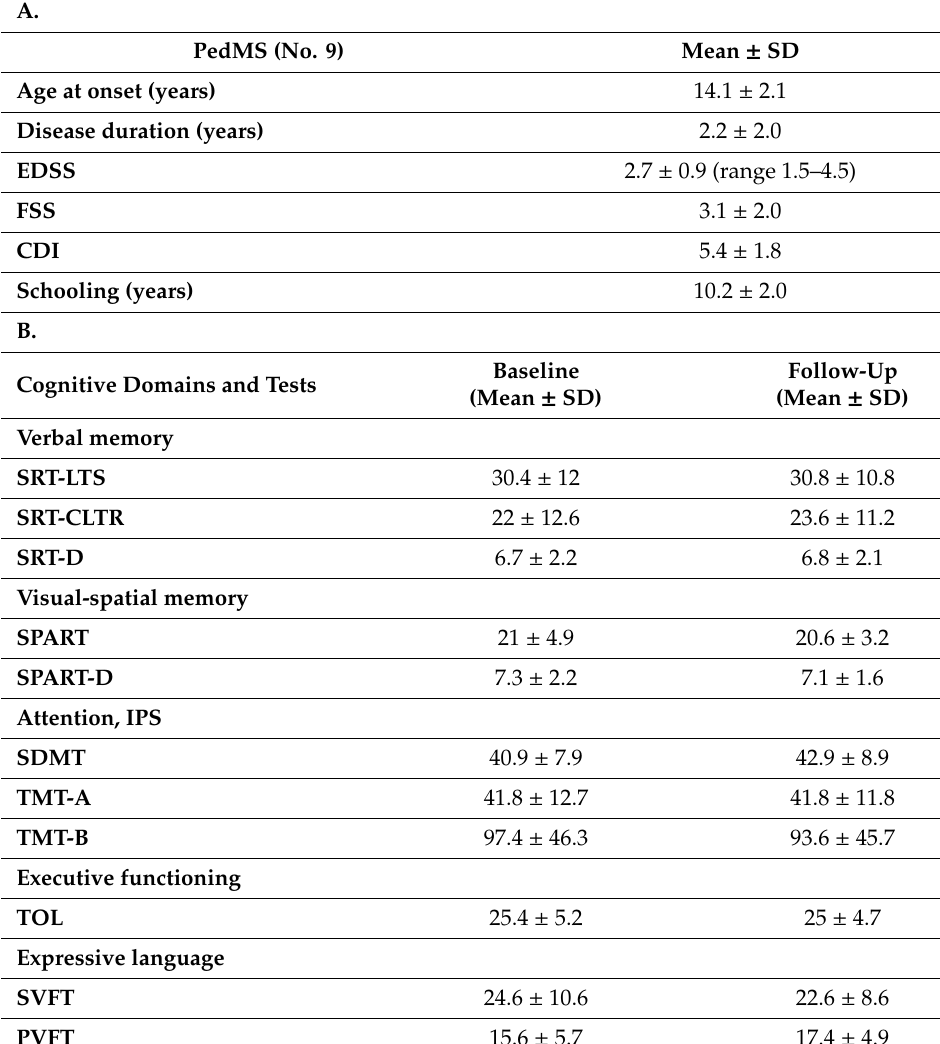
Table 1. A: demographic and clinical features of the investigated pediatric multiple sclerosis (PedMS) patients (at baseline). B: Mean scores ( ± SD) obtained at the neuropsychiatric tests (baseline and